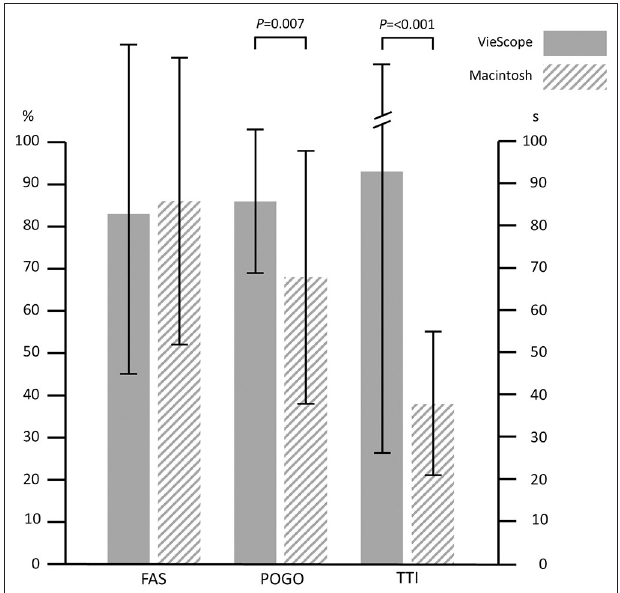
FIGURE 2 | First attempt success rates, visualization, and time to intubation. FAS, First attempt success rate; POGO, Percentage of Glottis Opening Scale; TTI, Time to intubation; Error bars indicate standard deviation.